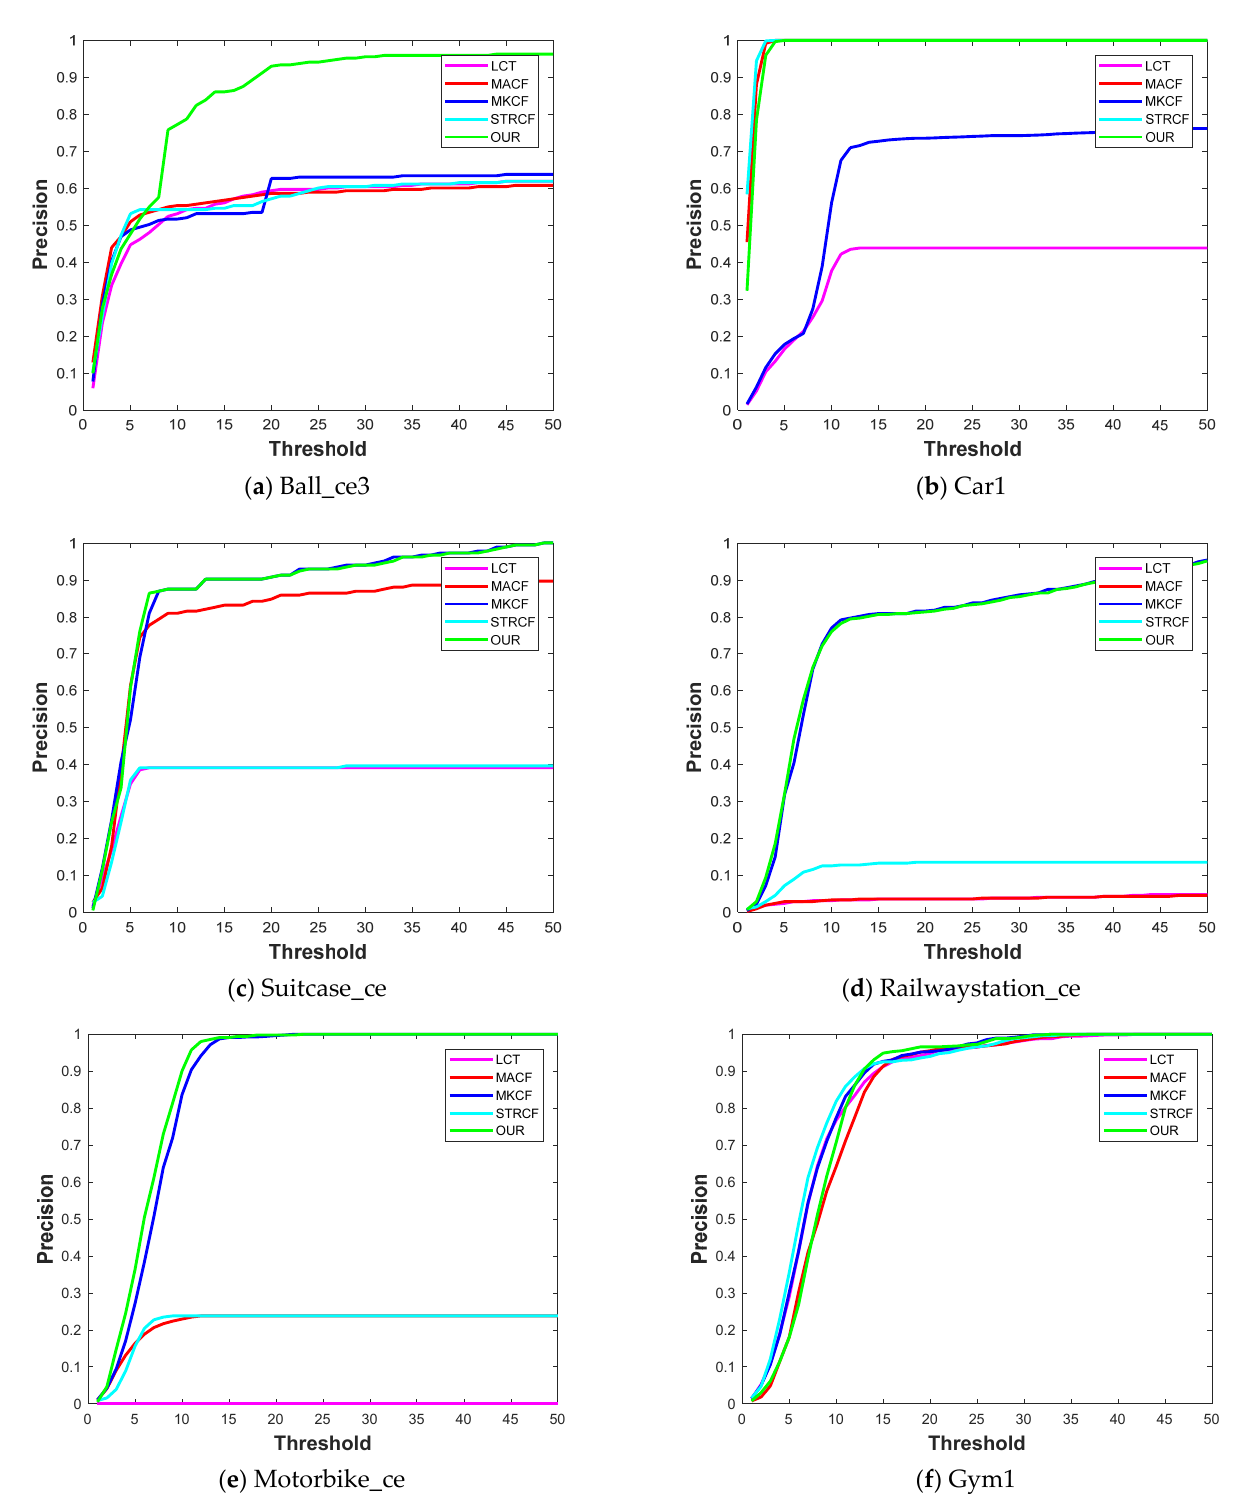
Figure 3. Quantitative analysis: comparison based on distance precision over a threshold of 20 pixels. Six videos selected from OTB-50, OTB-100, and Colour-128 datasets.